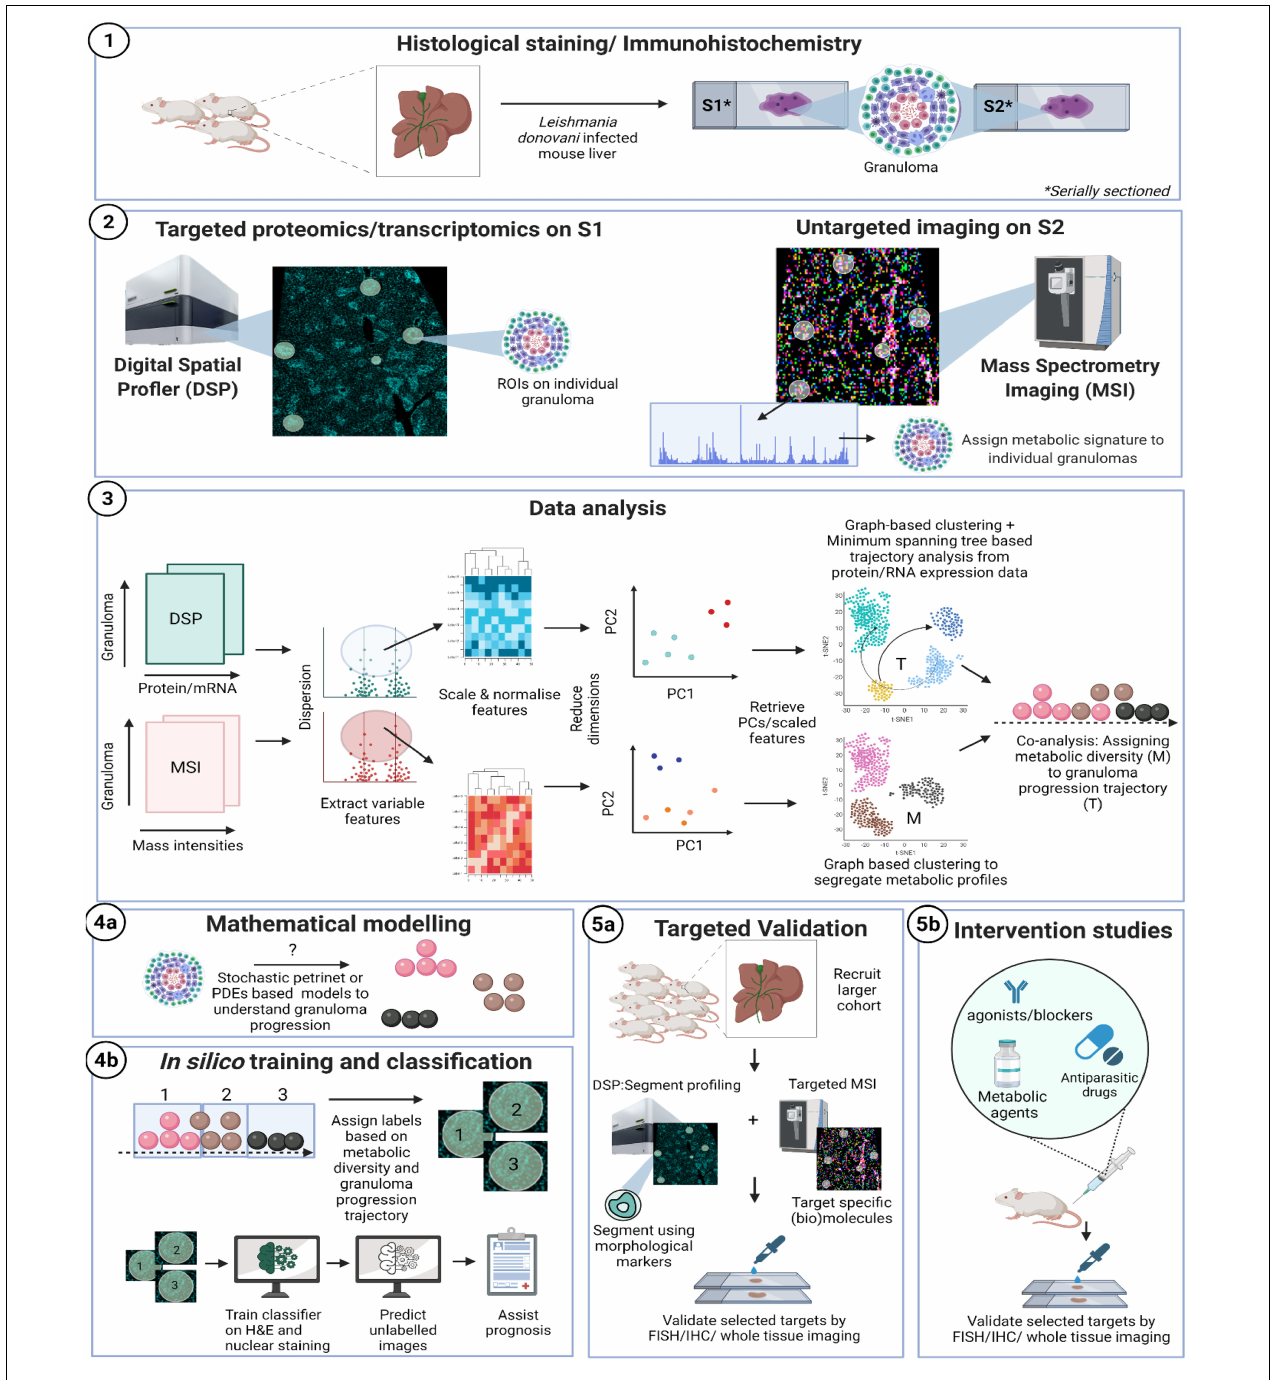
FIGURE 1 | Proposed workflow: (1) classical hematoxylin and eosin (H&E) or nuclear staining of a mouse liver, infected with Leishmania donovani can be used to select granulomatous regions of interest (ROI). (2) Thin serial sections (5 µ m) processed in parallel through GeoMx Digital Spatial Profiler (DSP; left) and mass spectroscopy imaging (MSI; right). For DSP: targeted morphology-based selection of ROIs can be probed using antibody-based protein profiling (e.g., mouse Immune Panel, NanoString). In parallel, MSI is used to analyze the whole tissue section at a predefined spatial resolution, typically 10–50 µ m pixel size. MSI imaging is used to generate the molecular masses of biomolecules (e.g., of lipids, metabolites, or proteins), depending on the sample’s pretreatment, from each pixel. MSI images can be either co-registered with the corresponding DSP-imaged area based on H&E/nuclear staining. (3) Data obtained from DSP and untargeted MSI imaging are processed in parallel to extract most variable features, which are then scaled, normalized, and finally visualized in reduced dimensions to assess microenvironment (ROI) heterogeneity through PCA. Principal components that explain most of the variance in the data are used to cluster granuloma subtypes based on proteomic/transcriptomic data (DSP) or their metabolic profile (MSI). Progression trajectory inferred from transcriptomic data is overlaid on metabolic